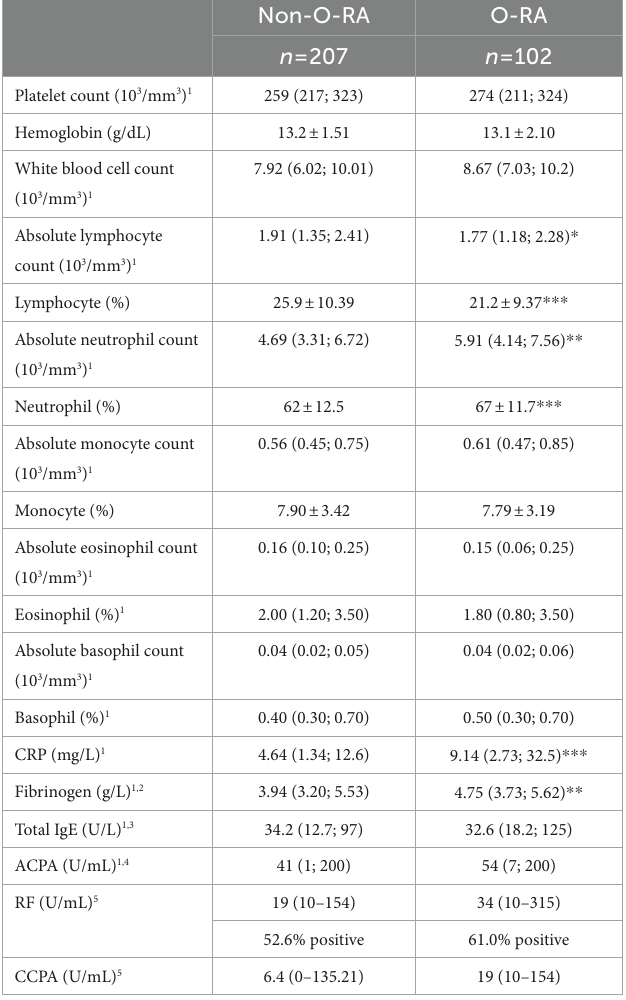
TABLE 3 Biological